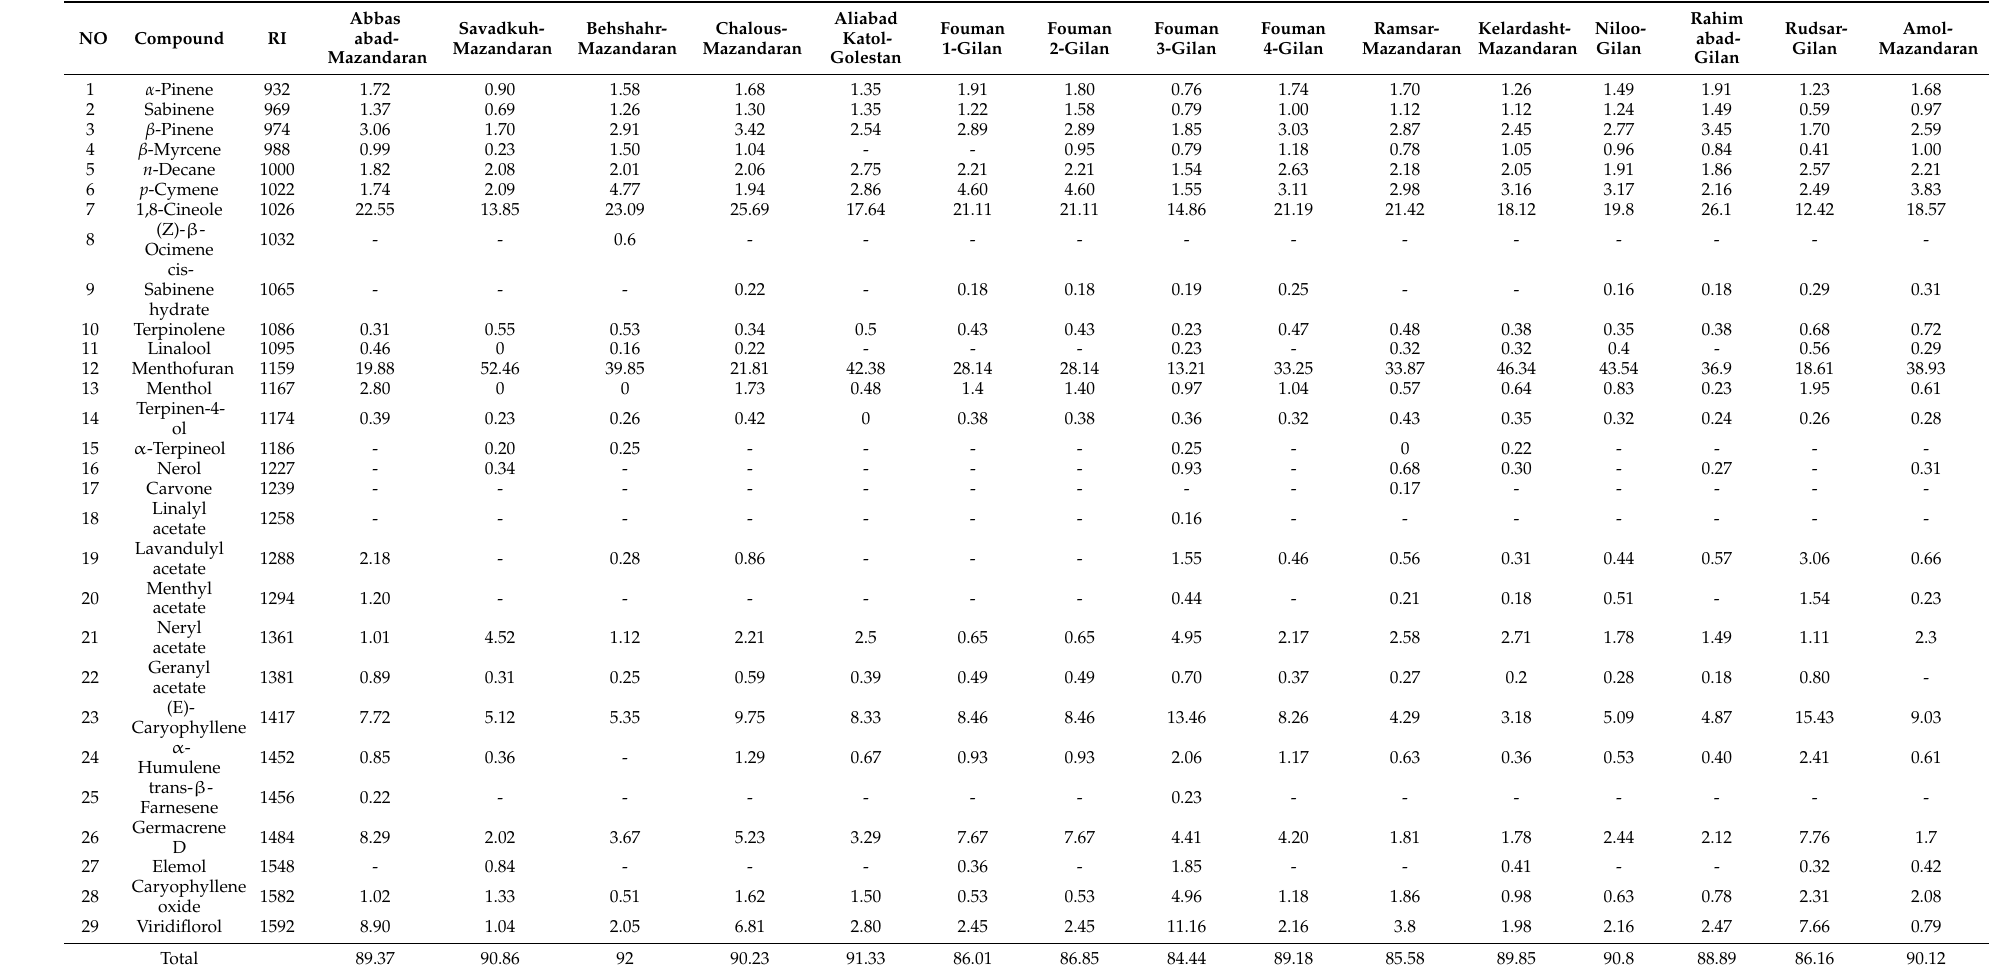
Table 3. Essential oil composition of M. aquatica populations from the Hyrcanian hotspot of